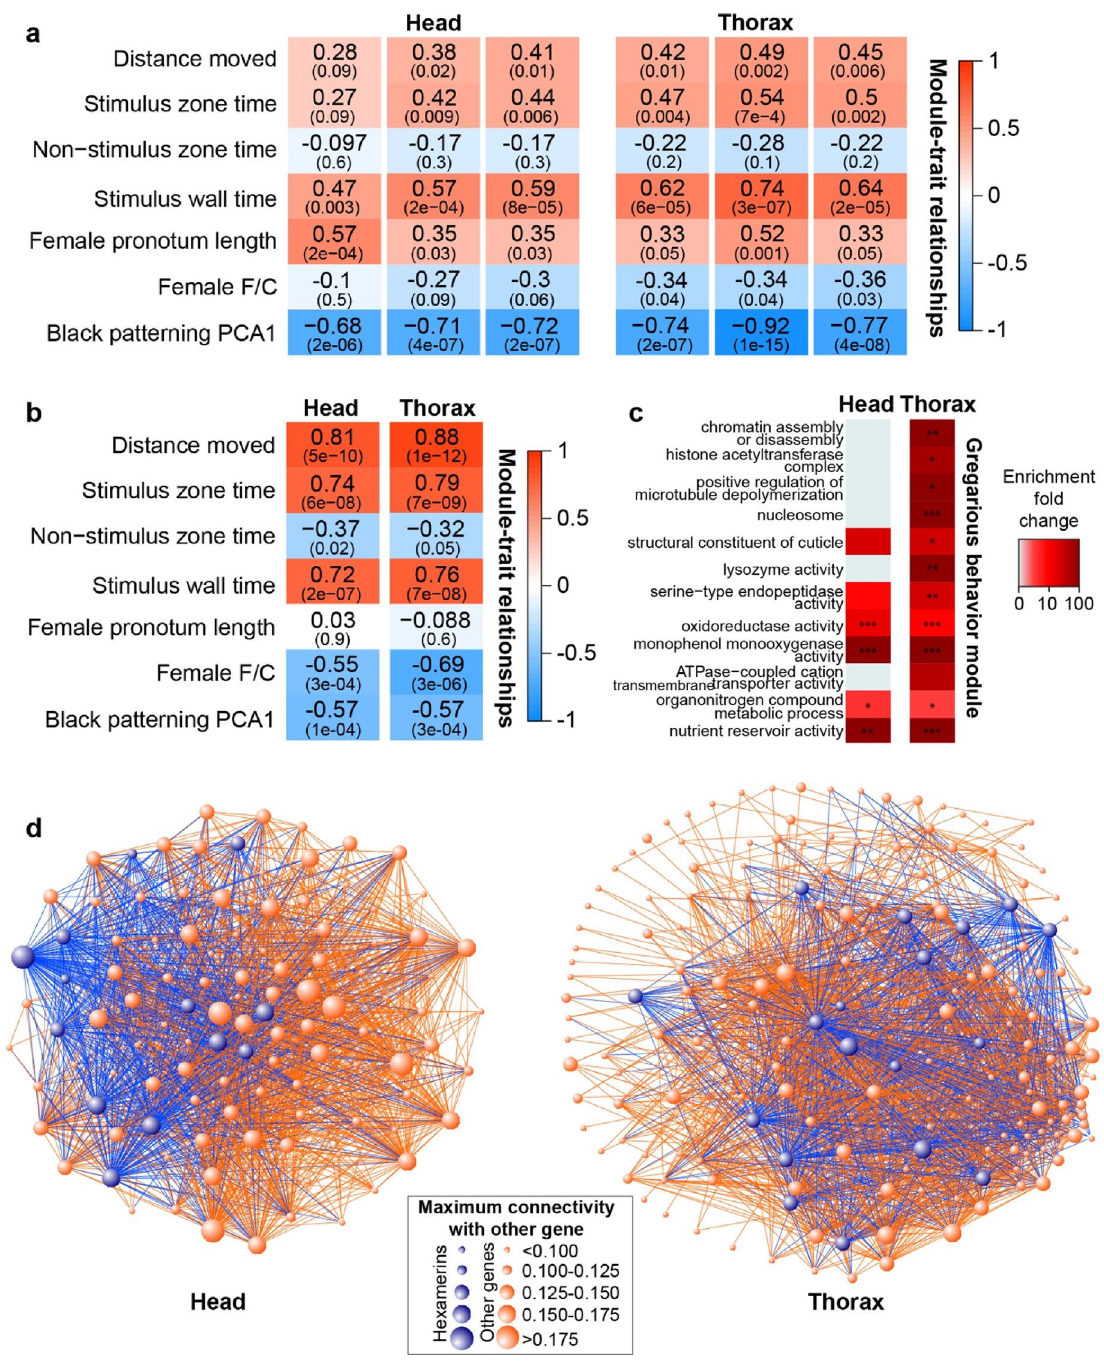
Figure 4. Groups of co-expressed genes exhibit high correlation with phenotypic traits. (a,b) Heat plots depicting correlations of different phenotypic traits and gene co-expression modules that are highly correlated with ( a ) nymphal colouration or ( b ) behaviour. Phenotypic trait values for sequenced values were inferred from the measured individuals. Stronger correlations are shown by more intense colours, with red signifying a positive correlation and blue a negative correlation. The upper number in each square represents the correlation value between the eigenvalue of the module and the behavioral trait, while the lower value refers to the associated p value, both calculated by WGCNA. ( c ) Heatmap showing enrichment of GO terms in the two gregarious behaviour modules with the respective piceifrons transcriptome as reference. GO terms were arbitrarily divided in four different groups. Darker colours refer to a higher fold change of enrichment in the density-responsive genes compared to the whole transcriptome. Significance was calculated with a Fisher exact test in Blast2GO, with as reference the transcriptome for the tested tissue and species (* p < 0.05, ** p < 0.01, *** p < 0.001). ( d ) Network graphs, made with VisANT v5.51, showing the connections between all genes included in the gregarious behavior module for the head tissue and for the thorax tissue. Larger dots represent genes with a higher connectivity. Blue dots represent hexamerin-like sequences and partial hexamerin-like sequences, which were generally found to have high connectivities. All other genes are coloured